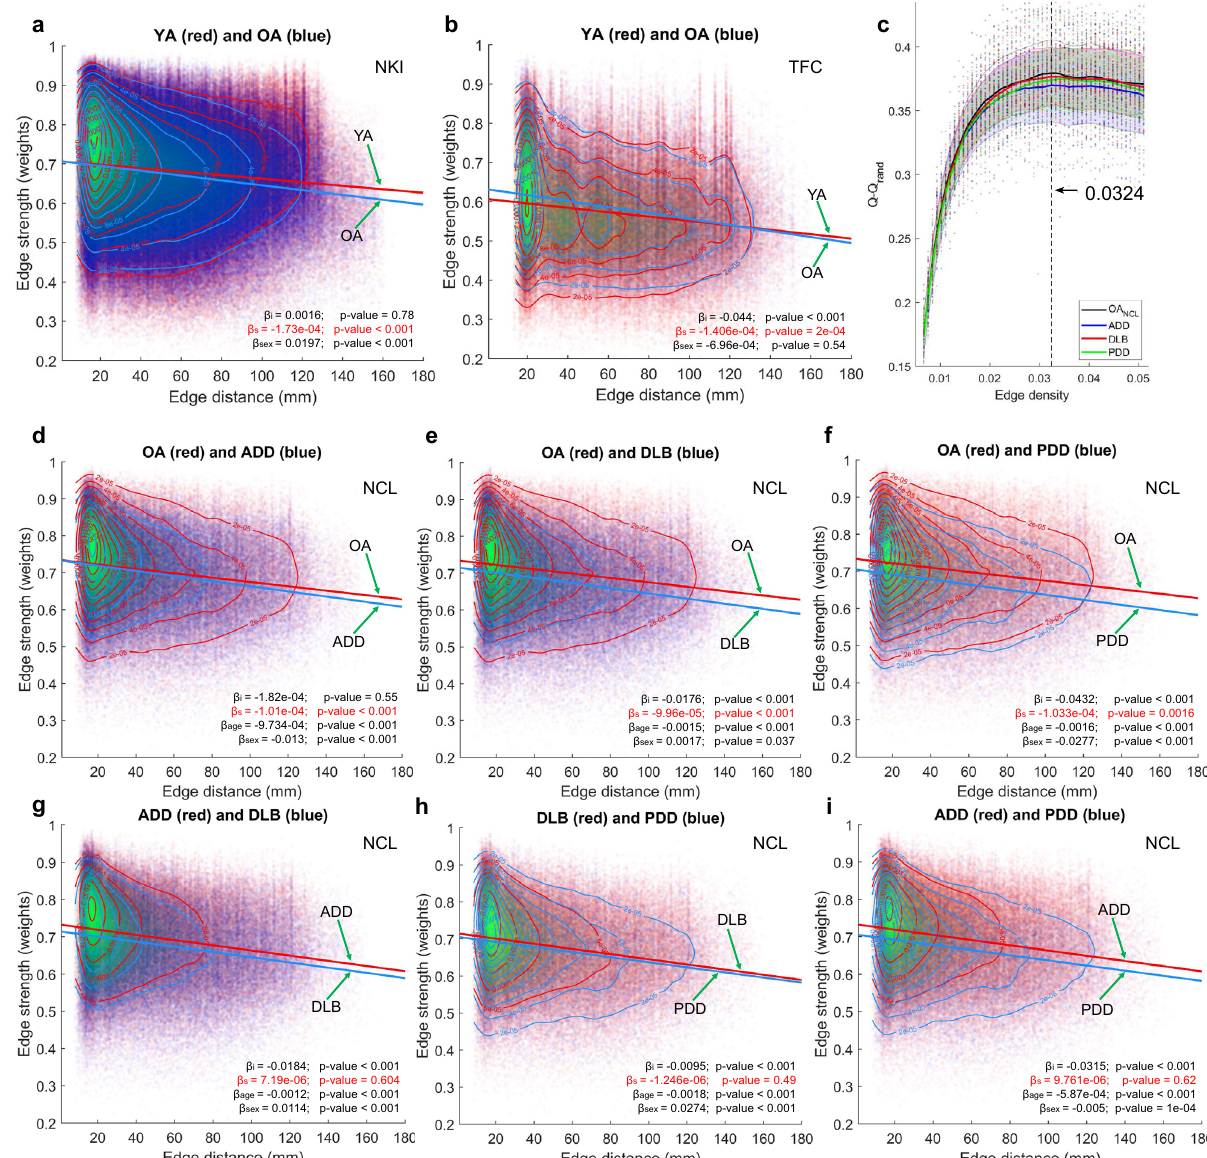
Fig. 2 Network edge strength versus Euclidian edge distance. a NKI; slope and intercept comparisons between edge strength and Euclidian distance pro fi les for the weighted thresholded connectivity matrices at optimal edge density, 3.8% with a 451-region of interest (ROI) atlas. b TFC; slope and intercept comparisons for the weighted thresholded connectivity matrices at optimal edge density, 5.11% with a 177 ROI atlas. c Optimal density estimation for the NCL cohort. Optimal edge density for all groups was reached at 3.24% with a 451 ROI atlas; see Supplementary Fig 2 for the rest of cohorts. The dashed lines and shaded error regions are the mean and standard deviation values across participants for each group, respectively. d - f NCL; slope and intercept comparisons between edge strength and Euclidean edge distance pro fi les comparing OA vs ADD ( d ), OA vs DLB ( e ) and OA vs PDD ( f ). The three neurodegenerative dementias showed a signi fi cantly steeper slope when compared with OA. g - i NCL; slope and intercept comparisons between dementias. The three dementia groups did not show differences in their slopes. Coef fi cients; β i = intercept difference, β s = slope difference, β age = age, β = sex ( p -value = 0.55) whereas the DLB and PDD groups showed a signi fi cant lower intercept ( p -value < 0.001). However, when comparing between dementias no signi fi cant slope differences were found, indicating that their strength-vs-distance connectiv- ity pro fi le was broadly similar, although their intercepts were different in all between-dementia comparisons ( p -value < 0.001).